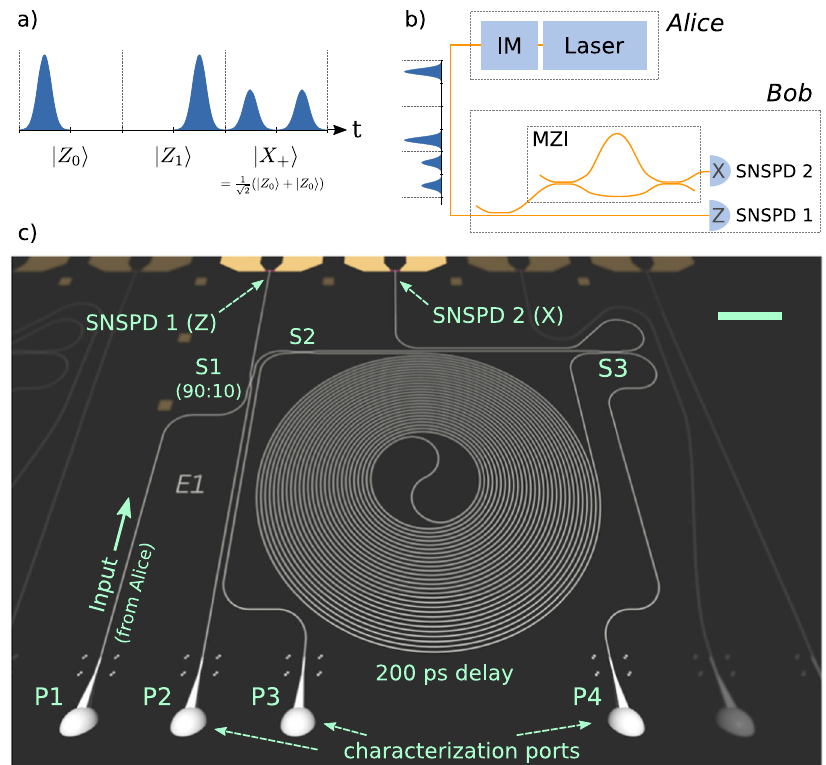
Fig. 1 Three-state time-bin QKD protocol. a For the simpli fi ed protocol, three different states from two bases are being used: Z 0 j i and Z 1 j i correspond to an early and a late time pulse and represent the bits 0 and 1, respectively. The third state X þ j i is the superposition state and is only used to estimate the phase error in the transmission. The coherent pulses are sent with two different intensity levels μ 1 and μ 2 as decoy state in order to detect photon number splitting attacks. b The states can be prepared by carving pulses with an intensity modulator (IM) from a CW laser on Alice ’ s side. On Bob ’ s side, the Z basis is measured directly using a superconducting nanowire single-photon detector (SNSPD) while the X basis is measured by placing an SNSPD at the output of an imbalanced Mach – Zehnder interferometer (MZI). c Rendering of the circuitry on the receiver chip. The input signal from Alice ’ s side is coupled into a waveguide through a 3D polymer coupler P1. Approximately 90% of the light is guided directly onto SNSPD 1, while the remainder is split by a directional coupler S1 into an MZI with a long delay line in one arm. The directional coupler S2 is designed to cancel out the additional waveguide loss in one arm by the delay line. SNSPD 2 is then used to monitor one output of the MZI. Ports P2, P3, P4 are used for calibration purposes only. Scale bar corresponds to 100 μ